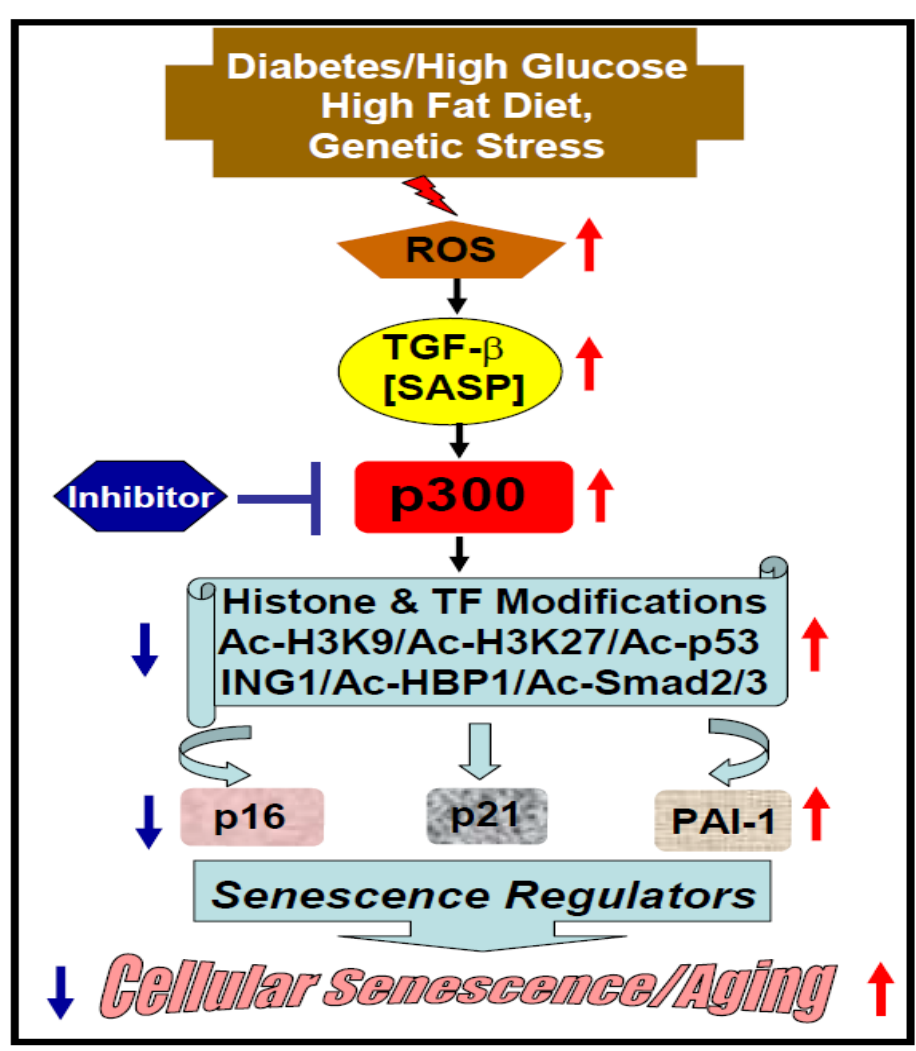
Figure 1. Model depicting the possible contribution of acetyltransferase p300 in cellular senescence/aging. ROS: Reactive Oxygen Species, TGF- β : Transforming Growth Factor- β . TF: Transcription factor, SASP: Senescence-Associated Secretory Phenotype, Ac: Acetylated histone/TF, ING1: Inhibitor of Growth 1.